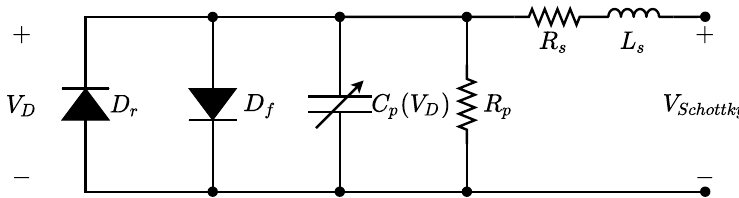
Figure 5. The proposed SPICE-compatible full circuital model of a Schottky